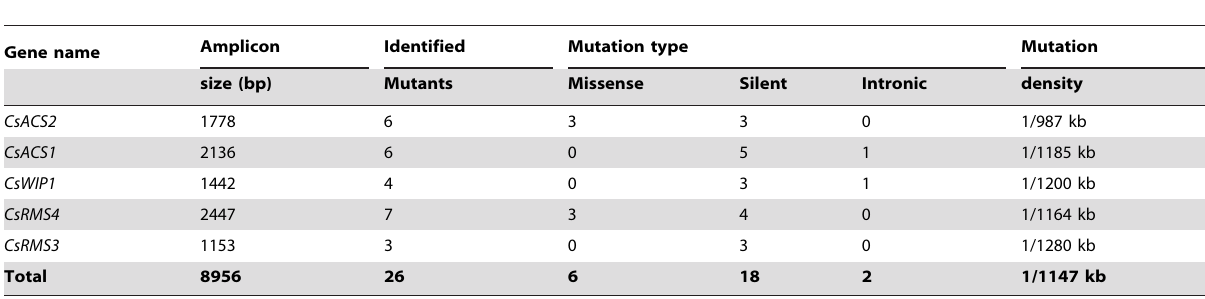
Table 3. Tilled genes and mutation frequency in the cucumber mutant